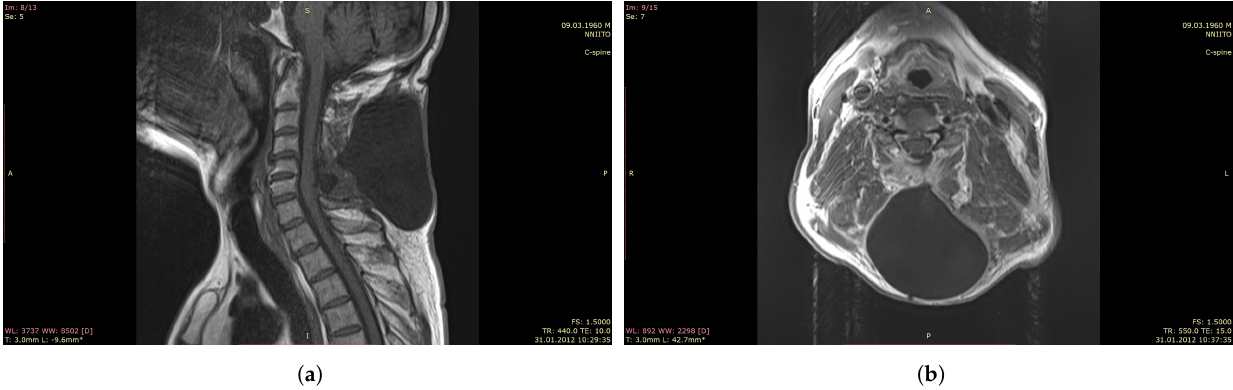
Figure 1. MRI of the cervical spine after removal of the spinal cord tumor and leaky suturing of the dura mater with the pseudomeningocele formation. ( a ): Sagittal plane, ( b ): Horizontal